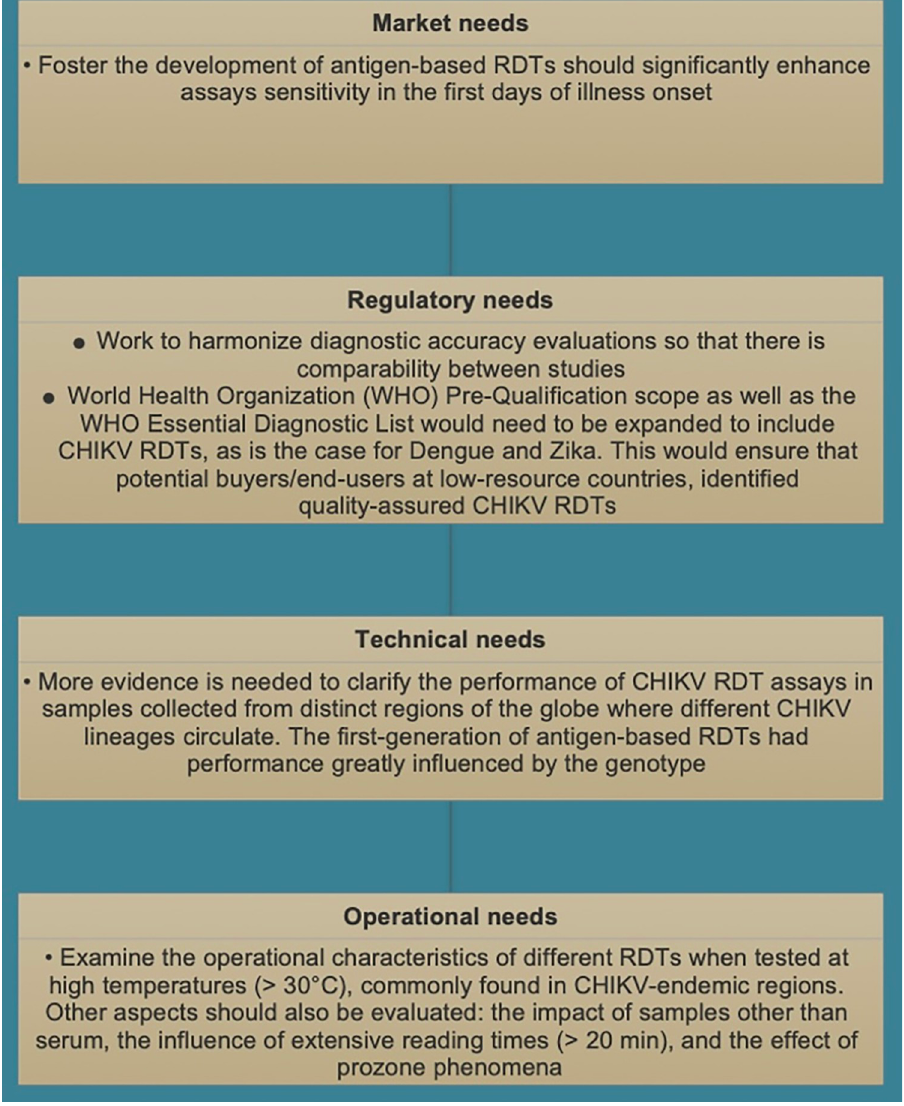
Fig 5. Future needs of immunoassay-based rapid diagnostic tests for CHIKV infection. CHIKV, Chikungunya; RDT, rapid diagnostic test; WHO, World Health